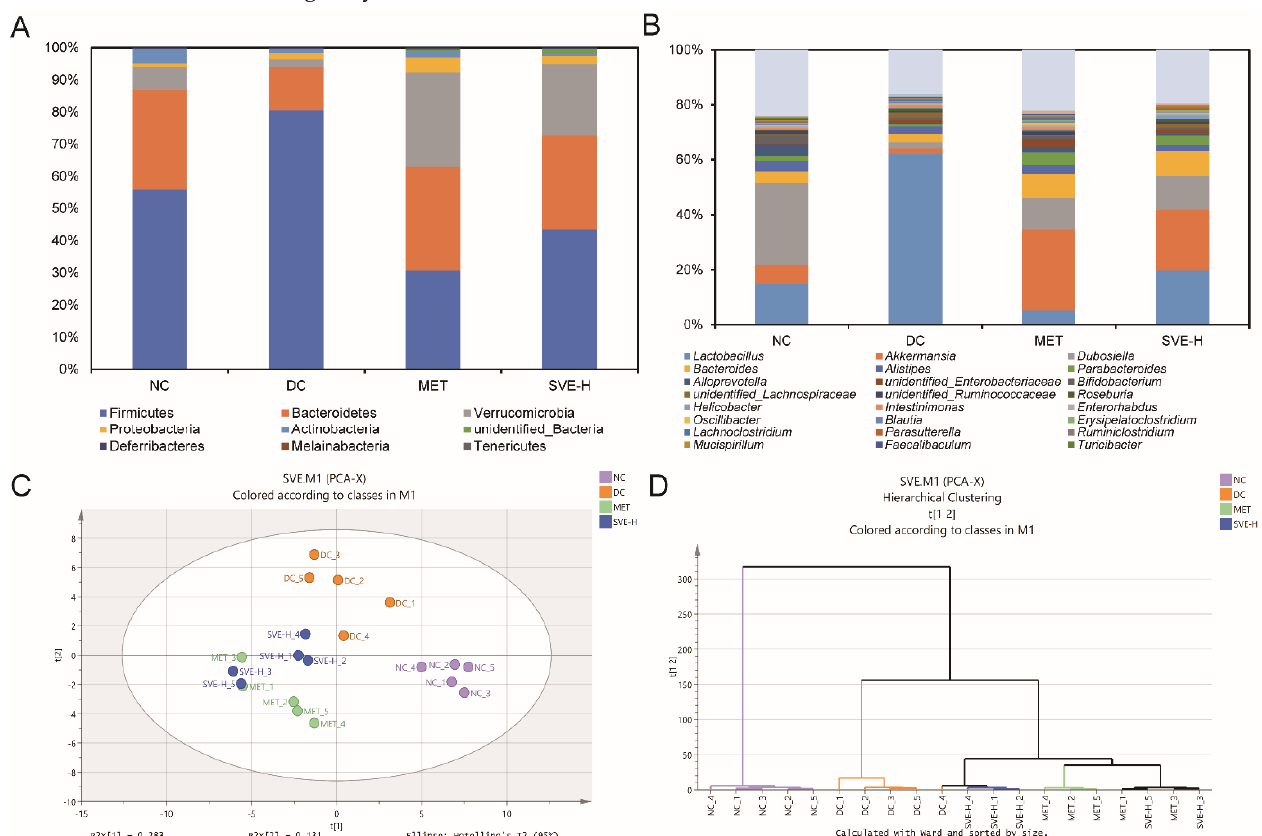
Figure 4. The components of gut microbiota at phylum ( A ) and genus ( B ) levels; PCA score ( C ) and hierarchical clustering ( D ) plots of gut microbiota at genus level in different groups.